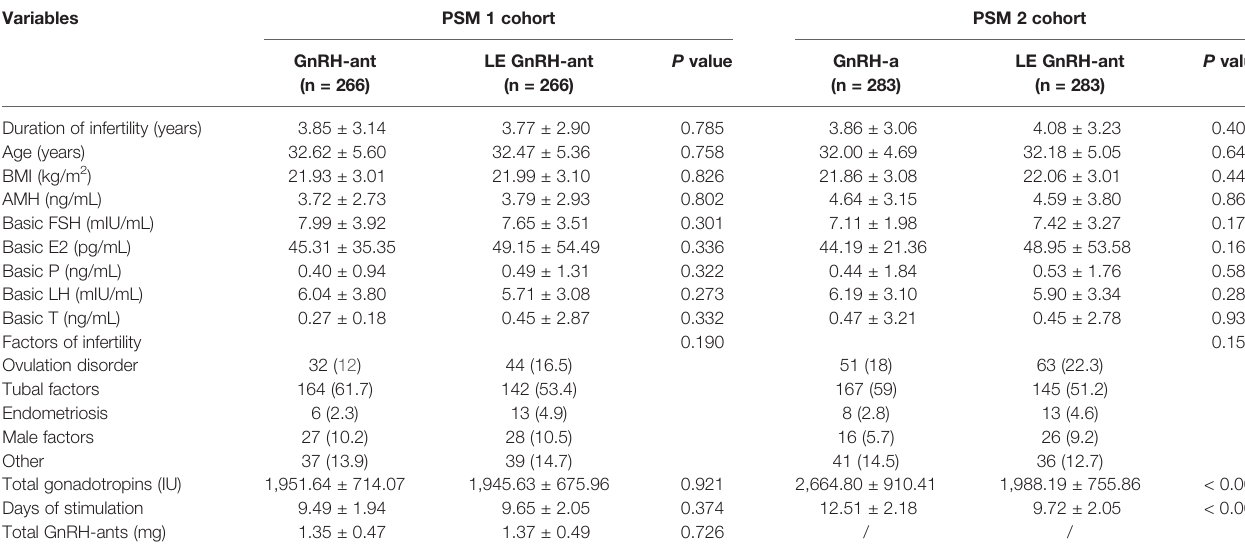
TABLE 1 | Baseline characteristics of patients and the features of ovulation induction after propensity score matching.